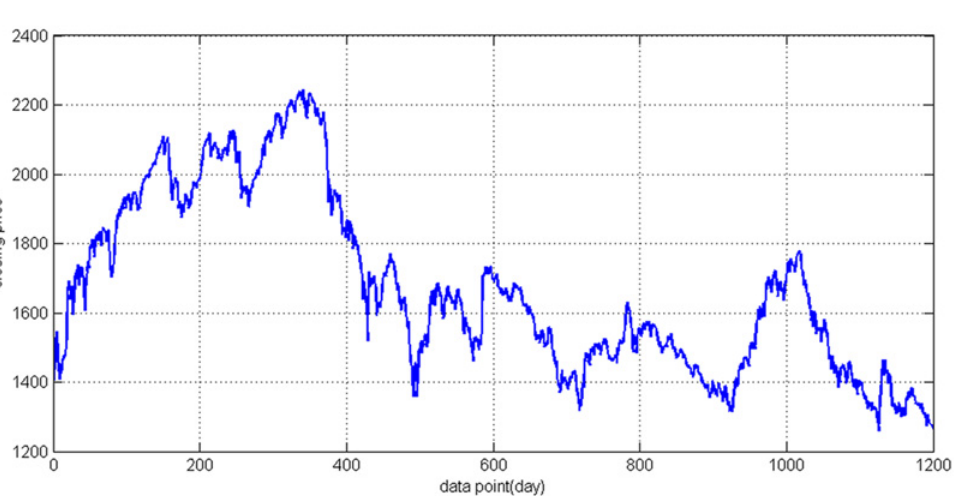
Fig 4. The closing price of raw data. Shanghai stock market index collected from 4 Jan. 2000 to 31 Dec. 2004 includes 1200 trading days' data. representing the past 20 days ’ data for each technical variable. The target output of a training sample is the closing price for the next day. Experiments are performed on a PC with 2.30GHz